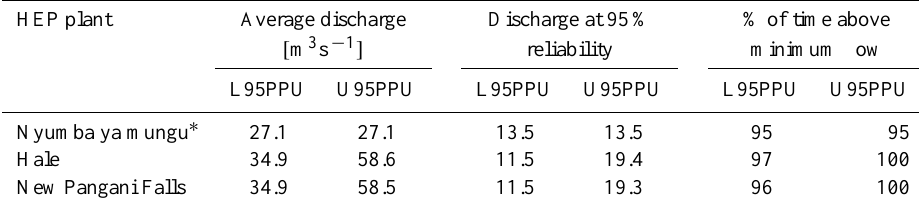
Table 6. Average discharge, discharge at 95% reliability ( Q 95%), and % of time discharge is above the minimum required flow at hy- dropower plant locations in the Pangani Basin. Upper (U95PPU) and lower (L95PPU) boundaries of the 95% prediction uncertainty are L95PPU and U95PPU values are therefore